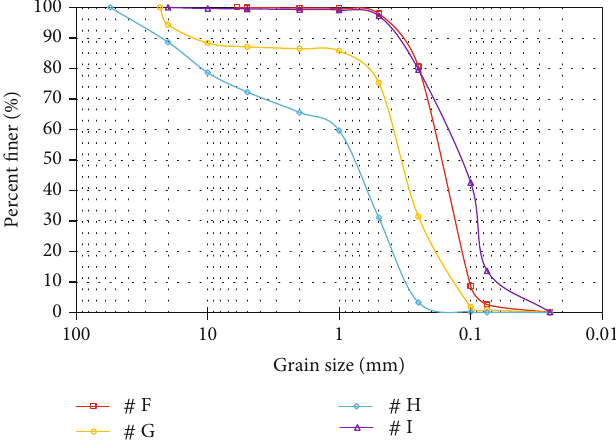
Figure 2: Grading curve of natural fi ne-grained sands numbered F ~ I.